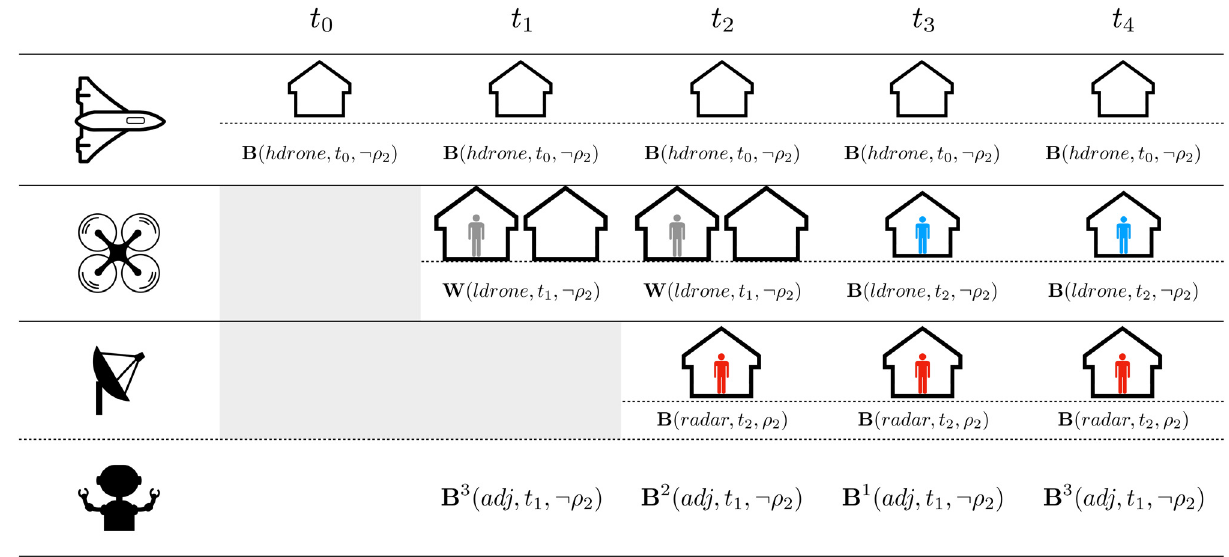
Figure 3: Overview of the scenario.